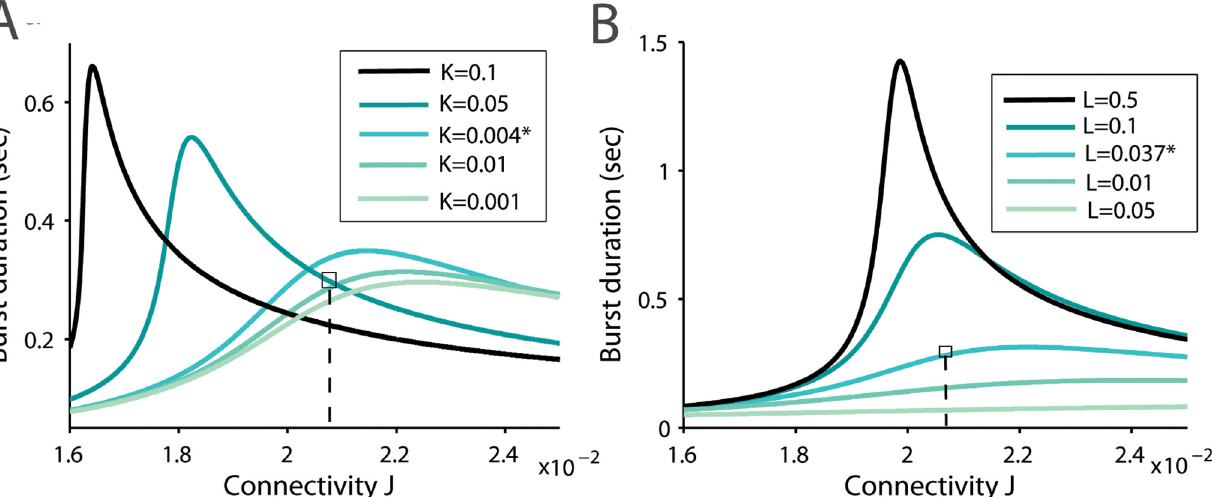
Fig 8. Reverberation time as a function of the synaptic connectivity (Slices). (A) Burst duration time as function of the network connectivity (parameter J ) for different values of the facilitation parameter K and (B) the depression parameter L , (other parameters are described in Table 1). We indicate the position of variable extracted for the experimental datas, which lie close to the